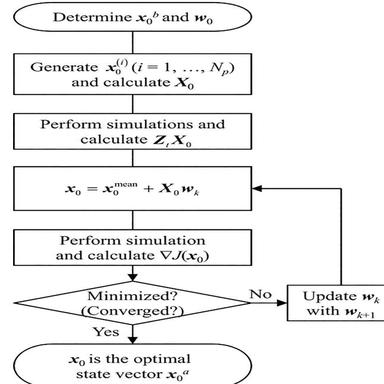
Flowchart to determine the optimal state vector x0 a by minimizing the cost function, J(w), using En4DVar.